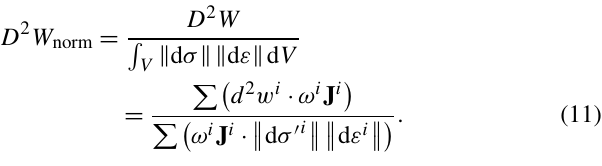
Figure 8. Geometry of the rock slope FEMLIP model. Stable bedrock (black layer) is chlorite–hornblende. The slide body (red) comprises chlorite schist. The interface between the black and red layers comprises a two-mica quartz schist functioning as the major geological